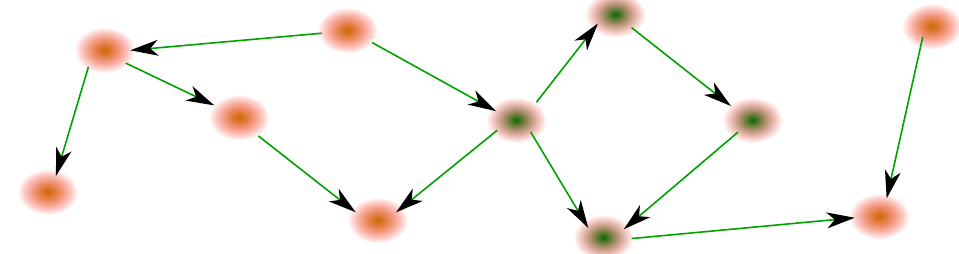
Figure 10. Provided that the red-nodes layer plays the role of boundary condition layer in Figure 9, the two directed layers network is mathematically equivalent to one unique network, whose node neighbors with the boundary layer nodes have a reaction term Γ applied for the diffusion of informa-